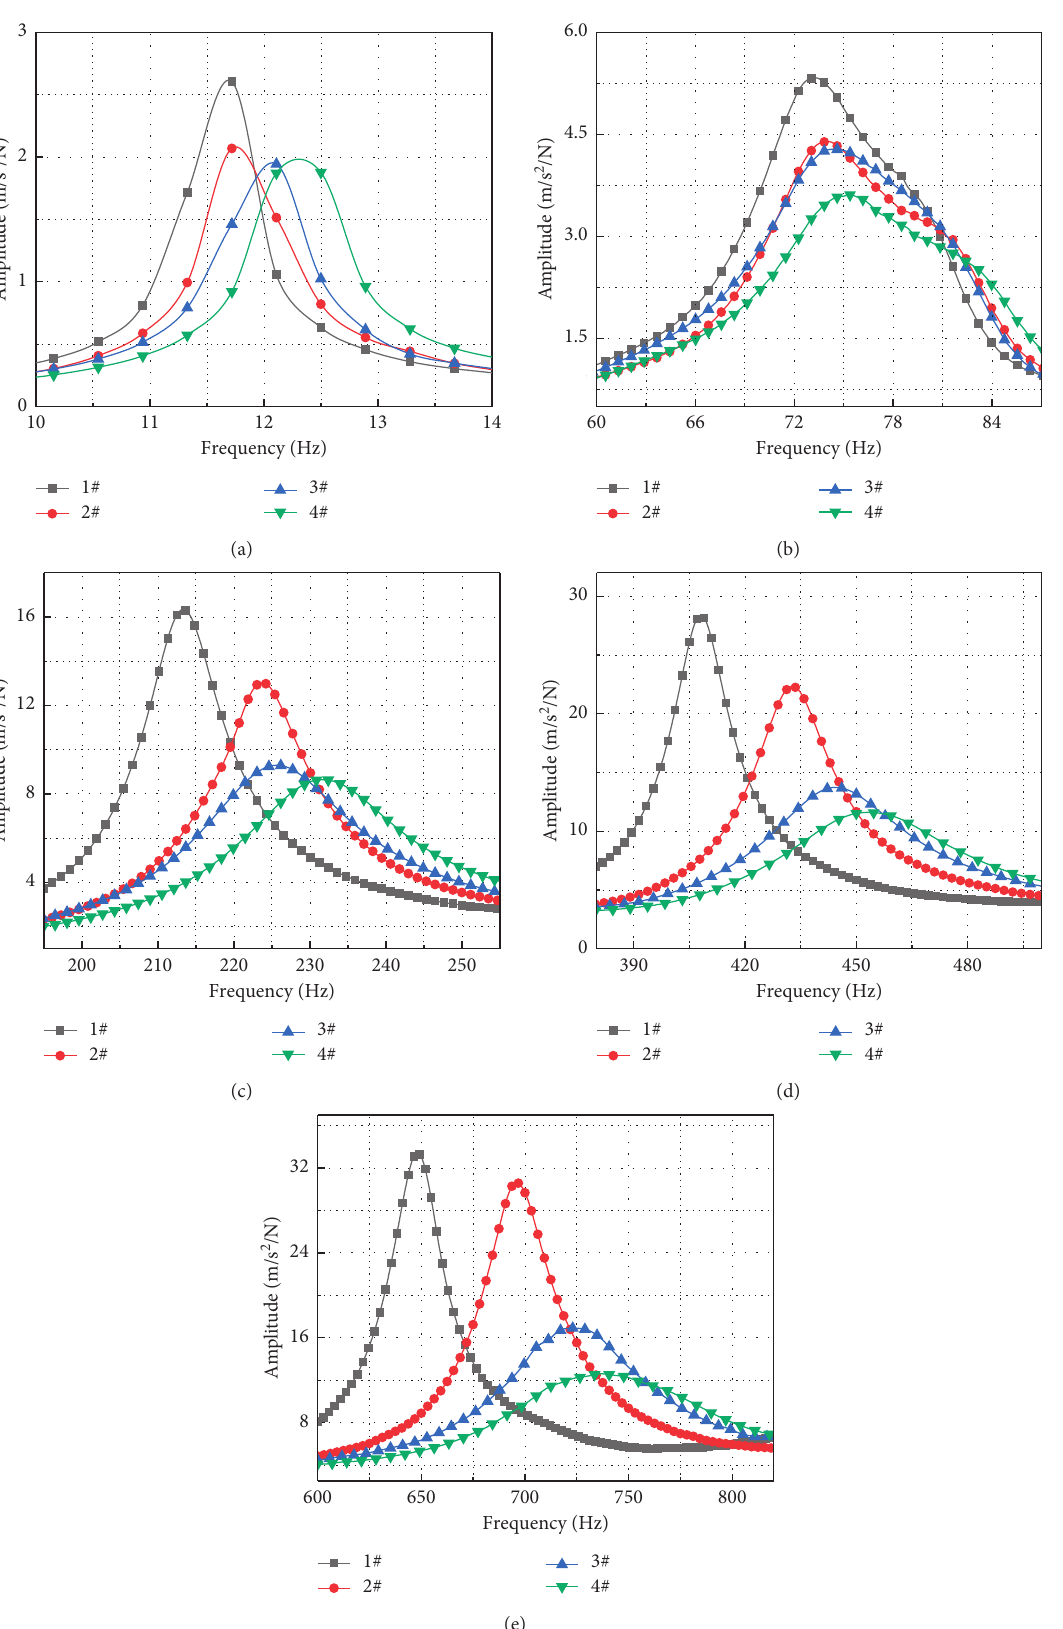
Figure 7: First five transfer function curves of cantilever beams 1# ∼ 4# (experimental temperature: 23.5 ° C). (a) Mode 1. (b) Mode 2. (c) Mode 3. (d) Mode 4. (e) Mode